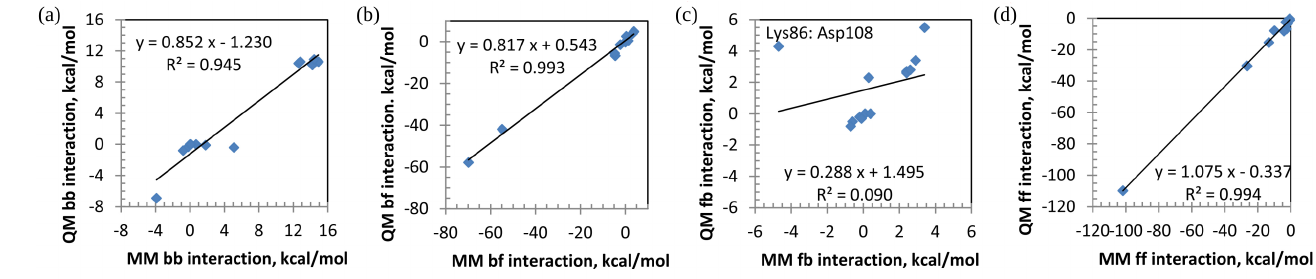
Figure 5. Correlation between pair interactions for conventional residues (res) divided into backbone (b) and functional (f) parts, MM vs. QM (solute): ( a ) bb, ( b ) bf, ( c ) fb, and ( d ) ff. For the distinction between bf and fb, see Table